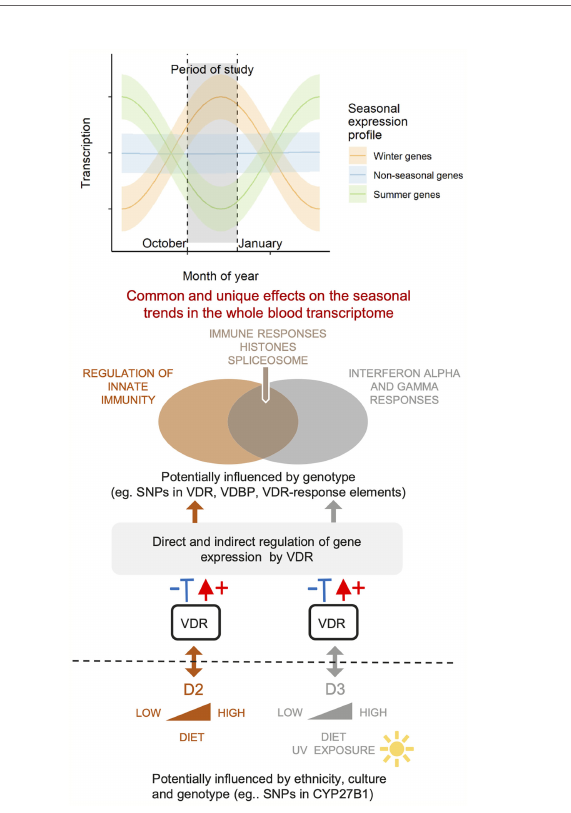
FIGURE 7 | A schematic diagram of this study in the context of genetic and seasonal factors that can in fl uence physiological vitamin D status and the whole blood transcriptome. Dietary supplementation with vitamin D 2 or D 3 boosts the native levels of the active forms of these vitamins in the blood, and generates overlapping but different effects on the seasonal trends in gene expression. Non-supplemented placebo subjects remain on their natural trajectories for levels of active D 2 and D 3 , and for their seasonal expression pro fi le. Selected differentially expressed pathways from this study are indicated on the Venn